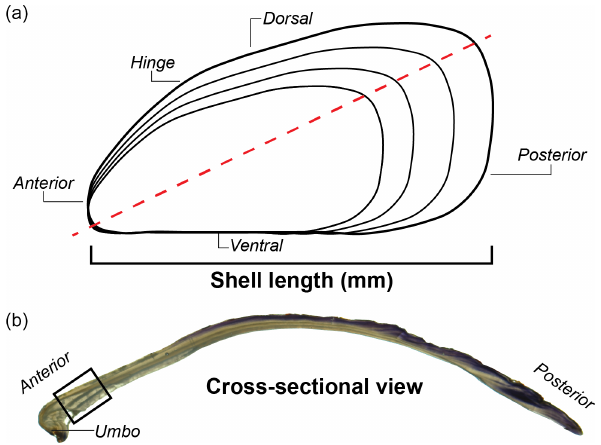
Figure 2. Anatomy of M. californianus whole valve and cross sec- tion. (a) Line drawing of whole valve showing where shell length was measured. Red dashed line denotes maximum growth axis along which the valve was cut to prepare a thin section. (b) Cross- sectional photograph of a shell taken under a microscope with re- flected light. Black box denotes region of interest where the maxi- mum valve cross-sectional thickness, the thickness of the innermost calcium carbonate layer, the color of the final growth band, and the width of the final growth band were measured or noted for all spec-